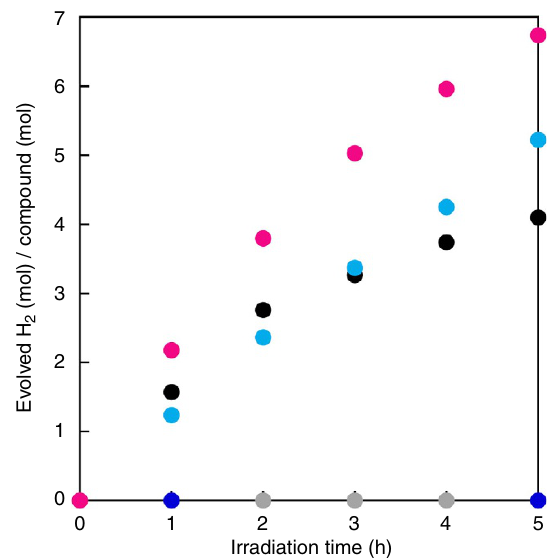
Figure 2 | Ultraviolet–visible–near infrared spectra of apH 2 -based photocatalysts in MeOH. [apH 2 (black line)] ¼ [apH (cid:2) (turquoise line)] ¼ 2mM; [ 1 (magenta line)] ¼ 1.35mM. The generation of apH (cid:2) was accomplished in situ by the treatment of apH 2 with TBAOH. The solid-state spectrum of 1 (KBr disk, blue line) is shown for comparison. The inset shows a magnification for the 300–900nm region of the solution spectrum of 1 .